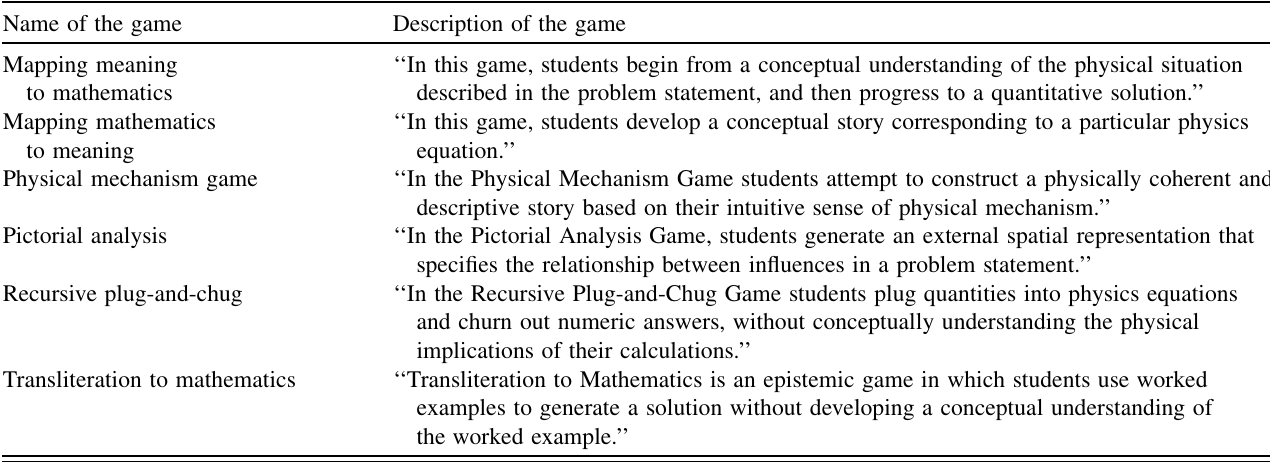
TABLE IX. List of epistemic games identified in Tuminaro and Redish